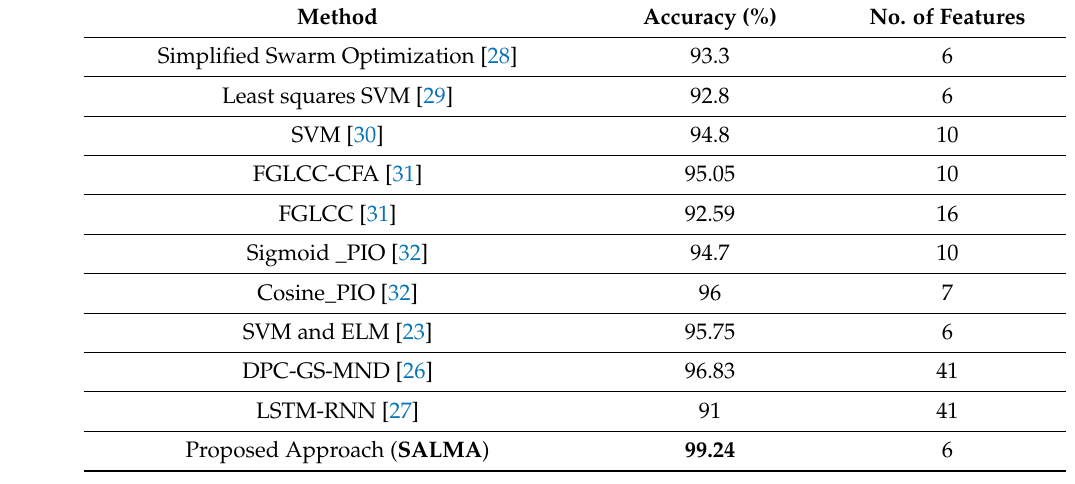
Table 8. Comparison between the proposed system and previous approaches on the KDD- CUP99 dataset.